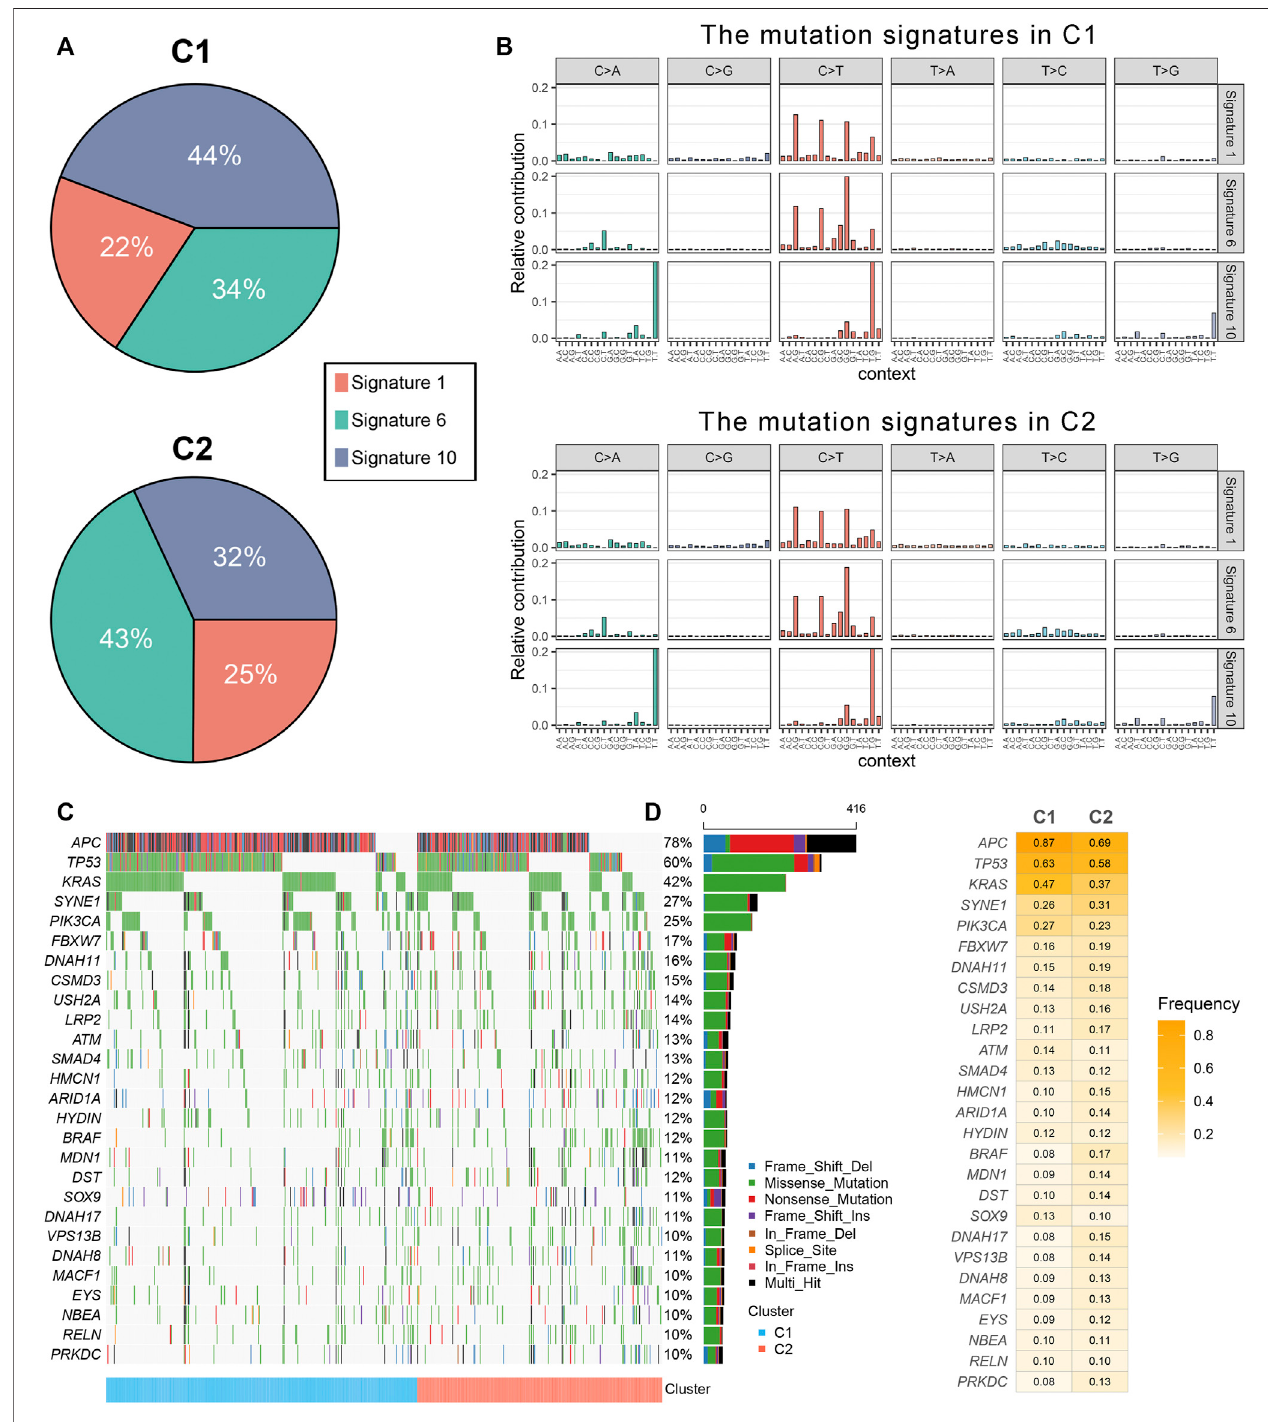
FIGURE3| Themutationallandscape oftwoimmune subtypes. (A) Threemutation signatureswereextracted from twoimmunesubtypeand namedaccordingto theCOSMICsignature.Theproportion ofeachmutationsignature,whichre fl ectsthelikelycarcinogenicfactors. (B) TherelativecontributionofthreesignatureinC1and C2. (C,D) The mutational landscape (C) and frequency (D) of 27 signi fi cant mutation genes (SMGs) in two subtypes.